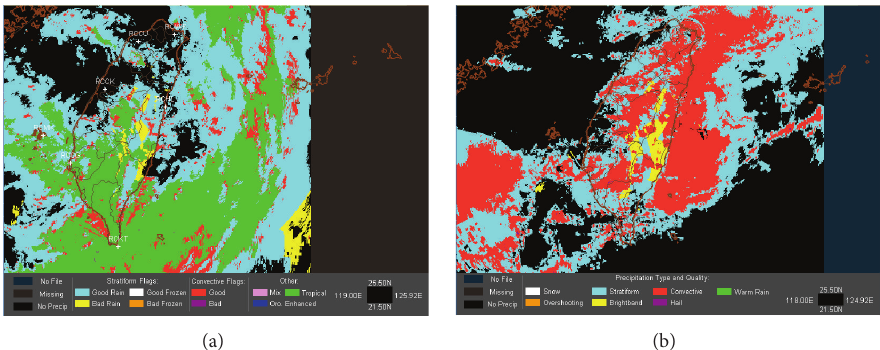
Figure 7: The precipitation classification result from (a) typhoon precipitation (0600 UTC 9 August 2009) and (b) mei-yu precipitation (0300 UTC 12 June 2012). The cyan, red, and green colors indicate the precipitation category is classified as stratiform, convective, and tropical precipitation.